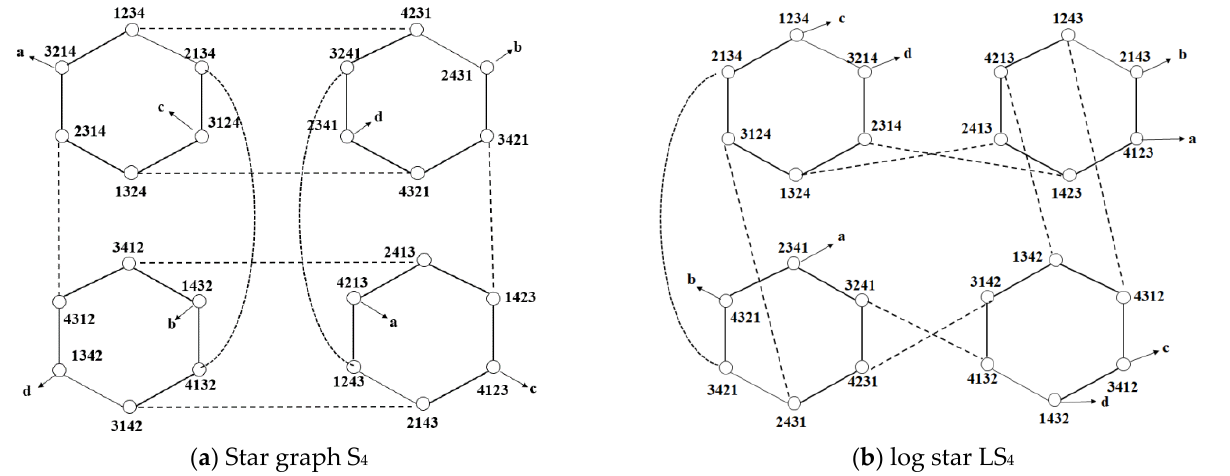
Figure 1. Four-dimensional star S 4 and log star LS 4 .